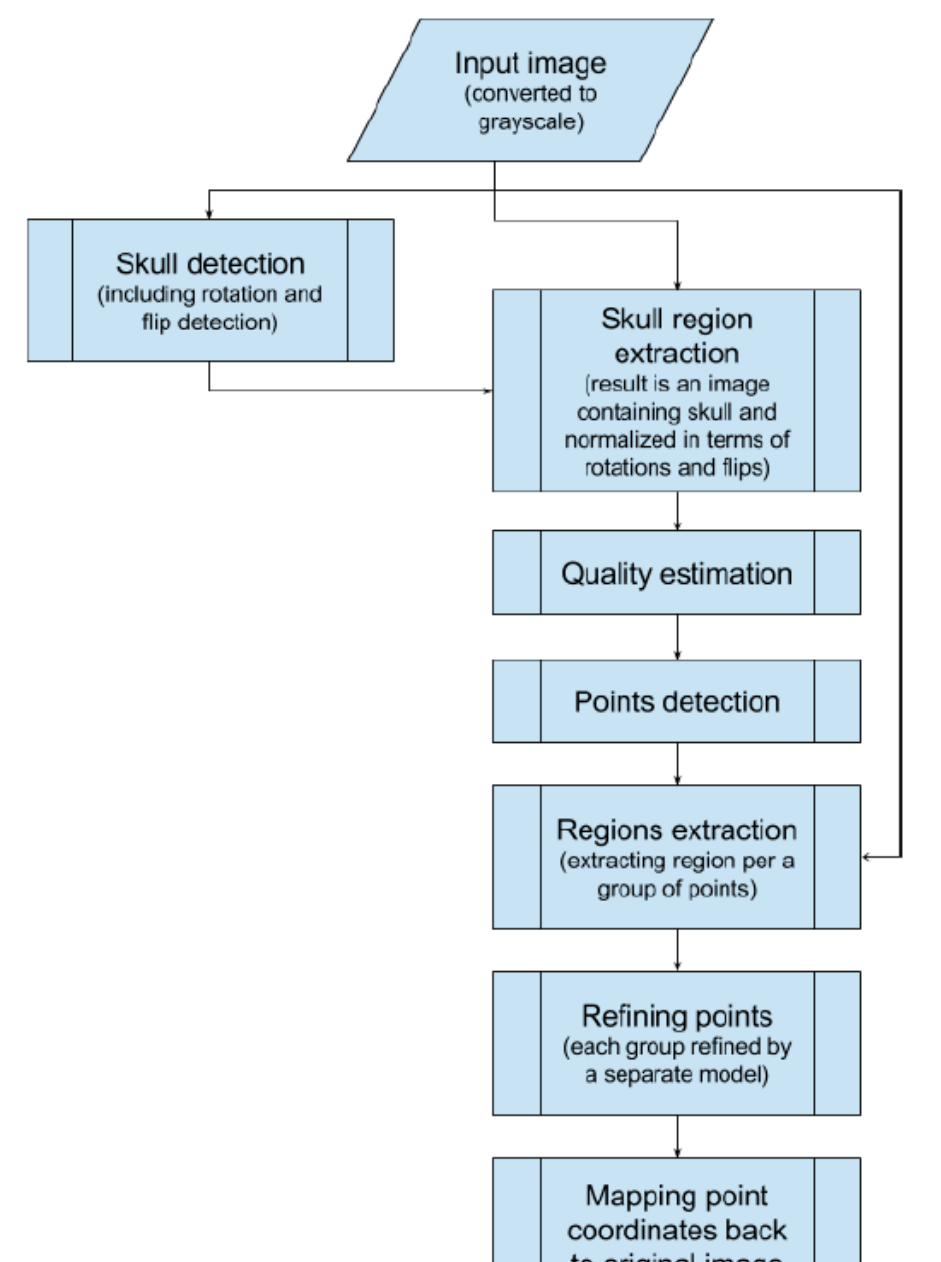
Figure 2. Description of phases of algorithm for detection of defined